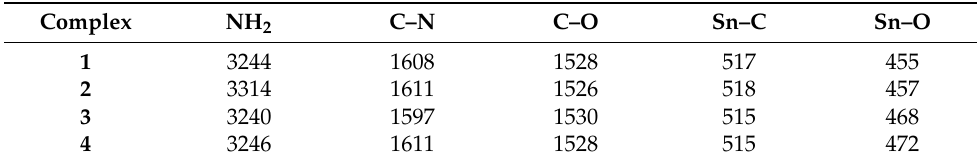
Table 2. IR spectral data of tin-naphthalene sulfonic acid complexes 1 – 4 .